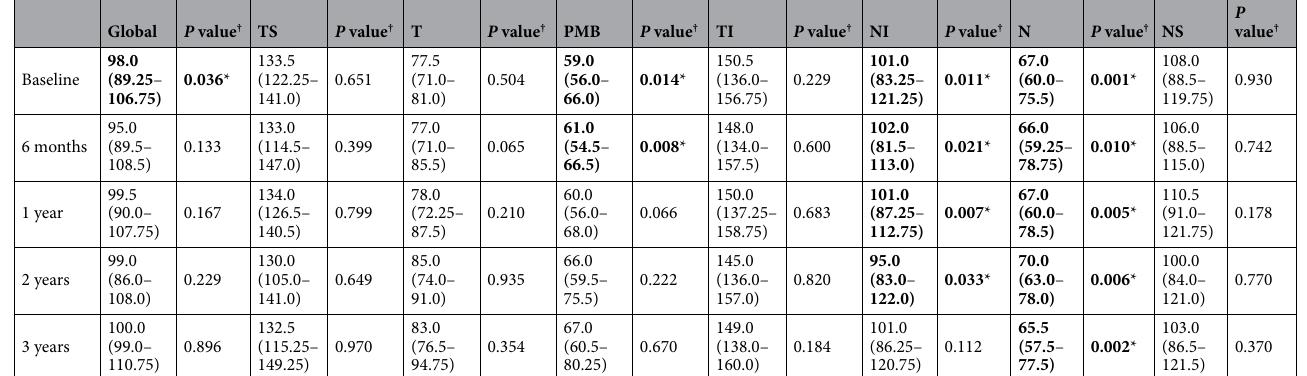
Table 4. Circumpapillary retinal nerve fiber layer thickness in fellows eyes of the eyes with retinal detachment. Significant values are in bold. Data are presented as median (interquartile range) of fellow eyes. *Denotes a significant difference ( P < 0.05). † Wilcoxon signed-rank test (comparison between eyes with retinal detachment presented in Table 3 and fellow eyes). G Global area, TS Temporal superior, TI Temporal inferior, NS Nasal superior, NI Nasal inferior, T Temporal, N Nasal, PMB Papillomacular